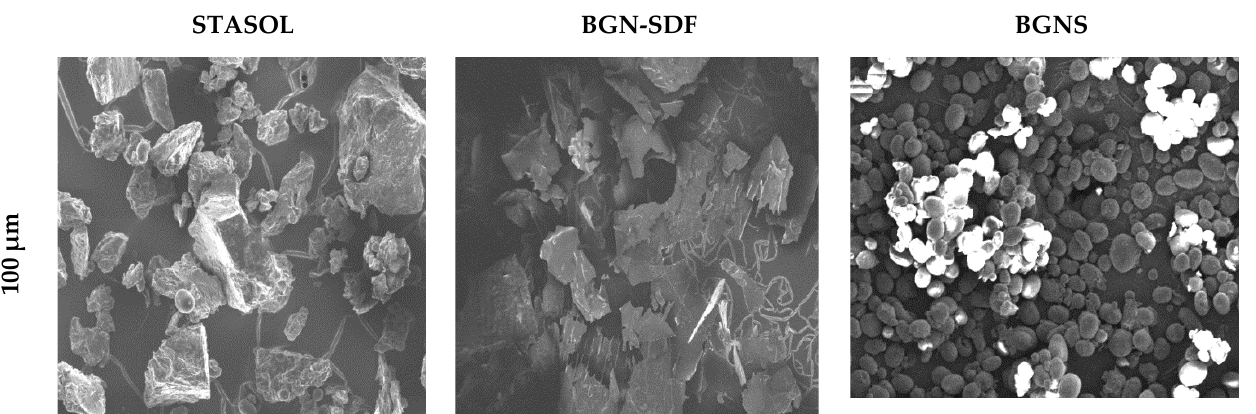
Figure 5. Microstructure of BGNS, BGN-SDF and STASOL. BGNS = Bambara groundnut starch; BGN-SDF = Bambara groundnut soluble dietary fibre; STASOL = Bambara groundnut starch-soluble dietary fibre nanocomposite.